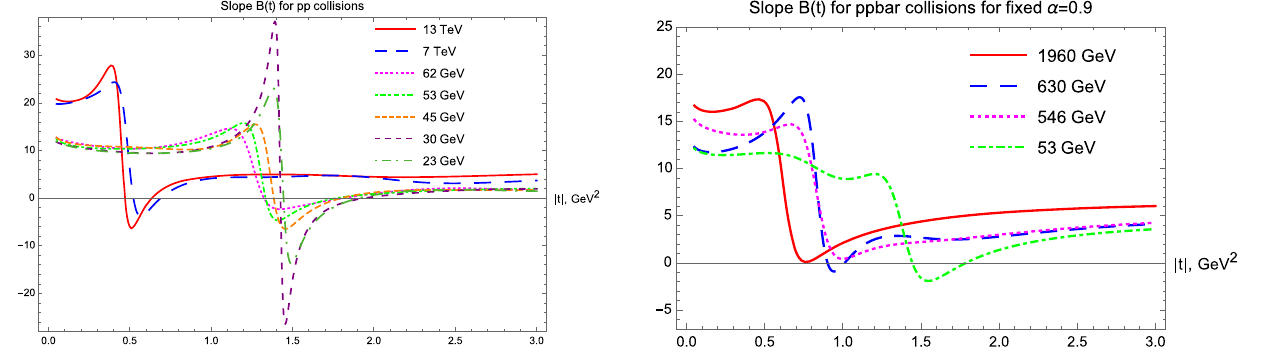
GeV − 2 , valid in a broad, 2 GeV − 2 wide range of | t | , with not